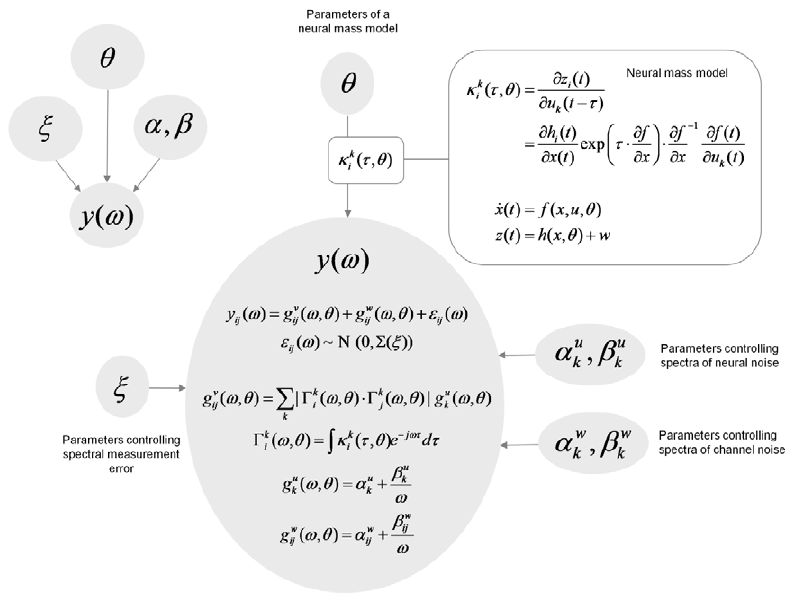
Figure 2. Generative model. This figure summarises the generative model as a Bayesian Network (upper left insert), which has been unpacked to show the form of the conditional dependencies in terms of the equations of the generative model (lower right). This model provides a probabilistic description of data in terms of the parameters that cause them. These include parameters controlling the spectral density of neuronal and channel noise and parameters controlling the variance of observation error on the cross-spectra predicted. The parameters of interest pertain to a neuronal model that is cast as a continuous-time state-space model. It is this neuronal model that constrains the mapping from neuronal noise or innovations to observed cross-spectra. The details of the neuronal (mass) model are provided in the next figure. Please see the main text for a detailed explanation of the equations that define the conditional dependencies.